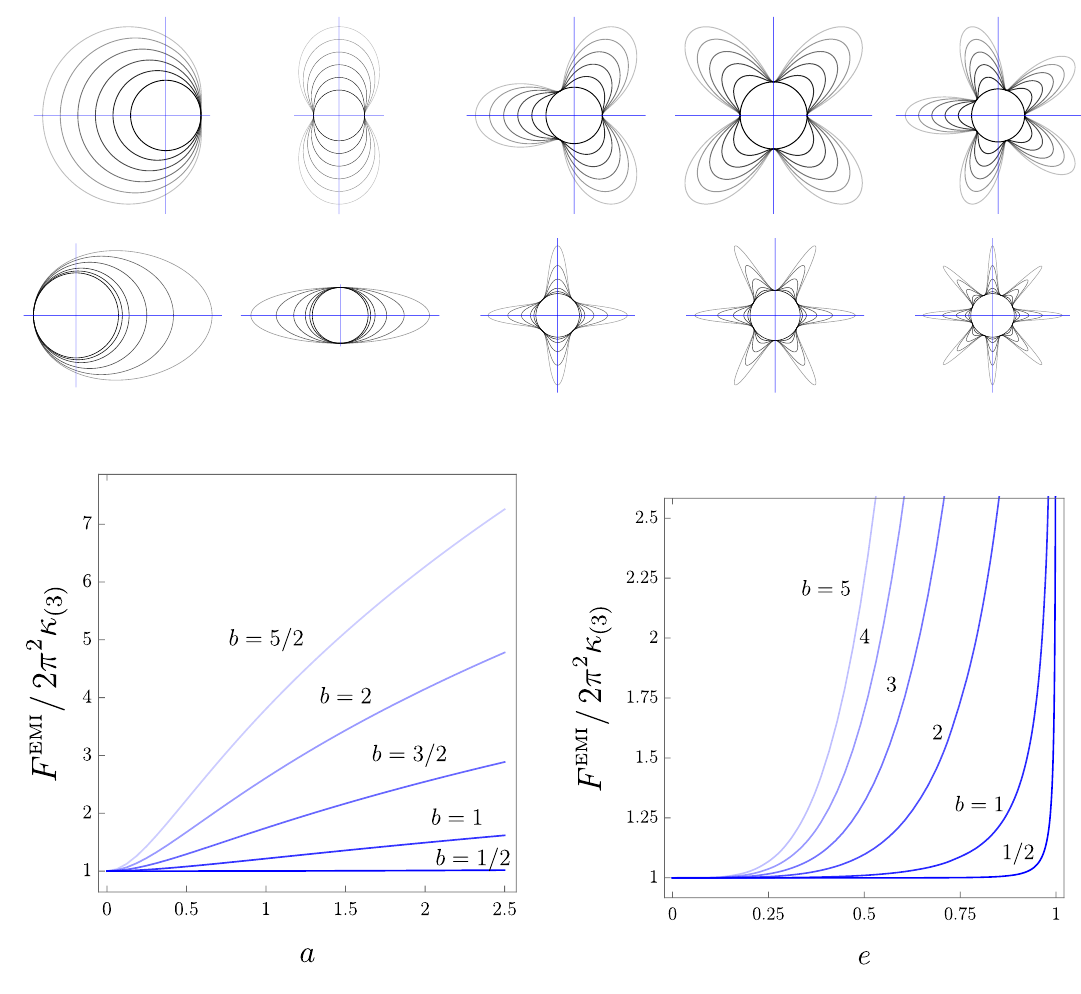
Figure 6 . (First row) We plot entangling regions parametrized by the function f ( θ ) = 1+ a sin 2 ( bθ ) for different values of a, b . From left to right we plot five figures corresponding to regions with b = 1 / 2 , 1 , 3 / 2 , 2 , 5 / 2 respectively. In each figure, the value a = 0 corresponds to the disk, and moving outwards we have regions corresponding to a = 1 / 2 , 1 , 3 / 2 , 2 , 5 / 2 . (Second row) We plot p entangling regions corresponding to f ( θ ) = 1 / 1 − e 2 cos 2 ( bθ ) for b = 1 / 2 , 1 / 2 , 3 , 4 , 5 (left to right plots). In each plot, the different figures correspond to different values of e ∈ (0 , 1) . (Third row) We plot the entanglement entropy universal coefficient F EMI , normalized by the disk value, as a function of a and e , respectively, for various values of b for each